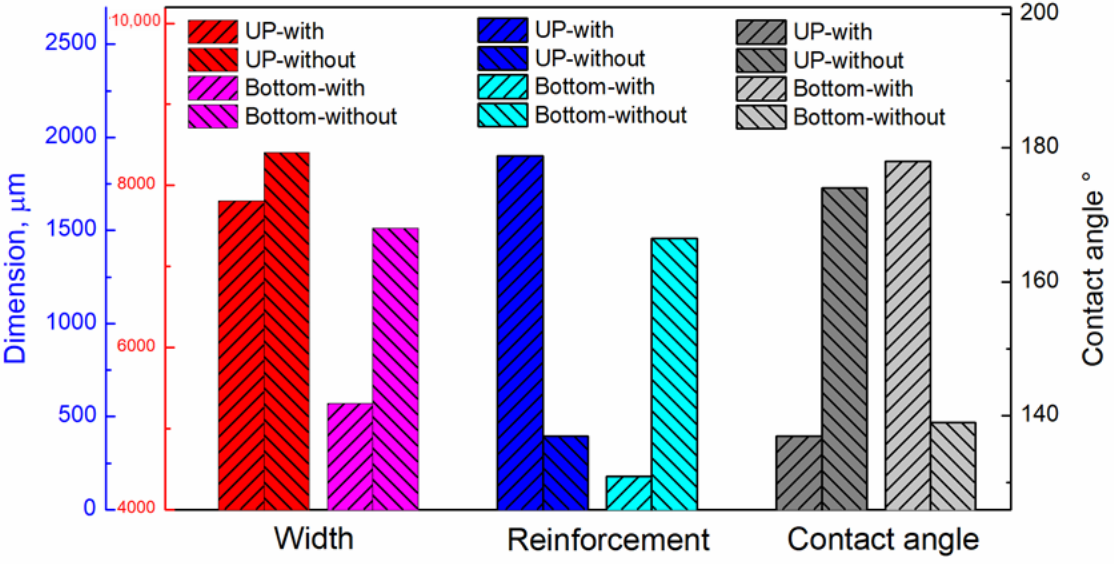
Figure 11. Comparison of bead dimensions with and without supporting plate.